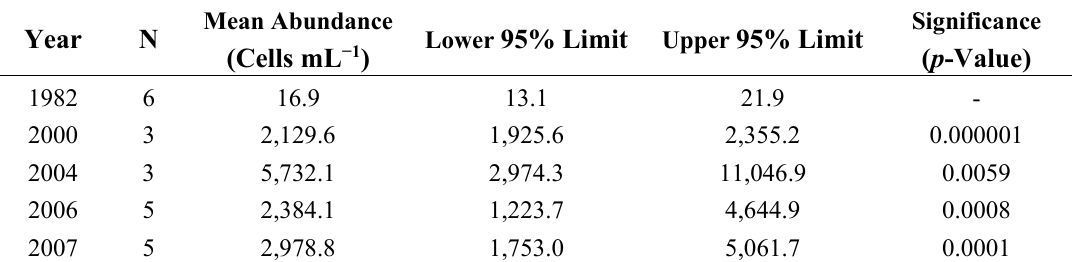
Table 2. Total cell abundance of cyanobacteria at station GB6 in Green Bay. Post-invasion years are 2000–2007. Summer means and 95% confidence limits were